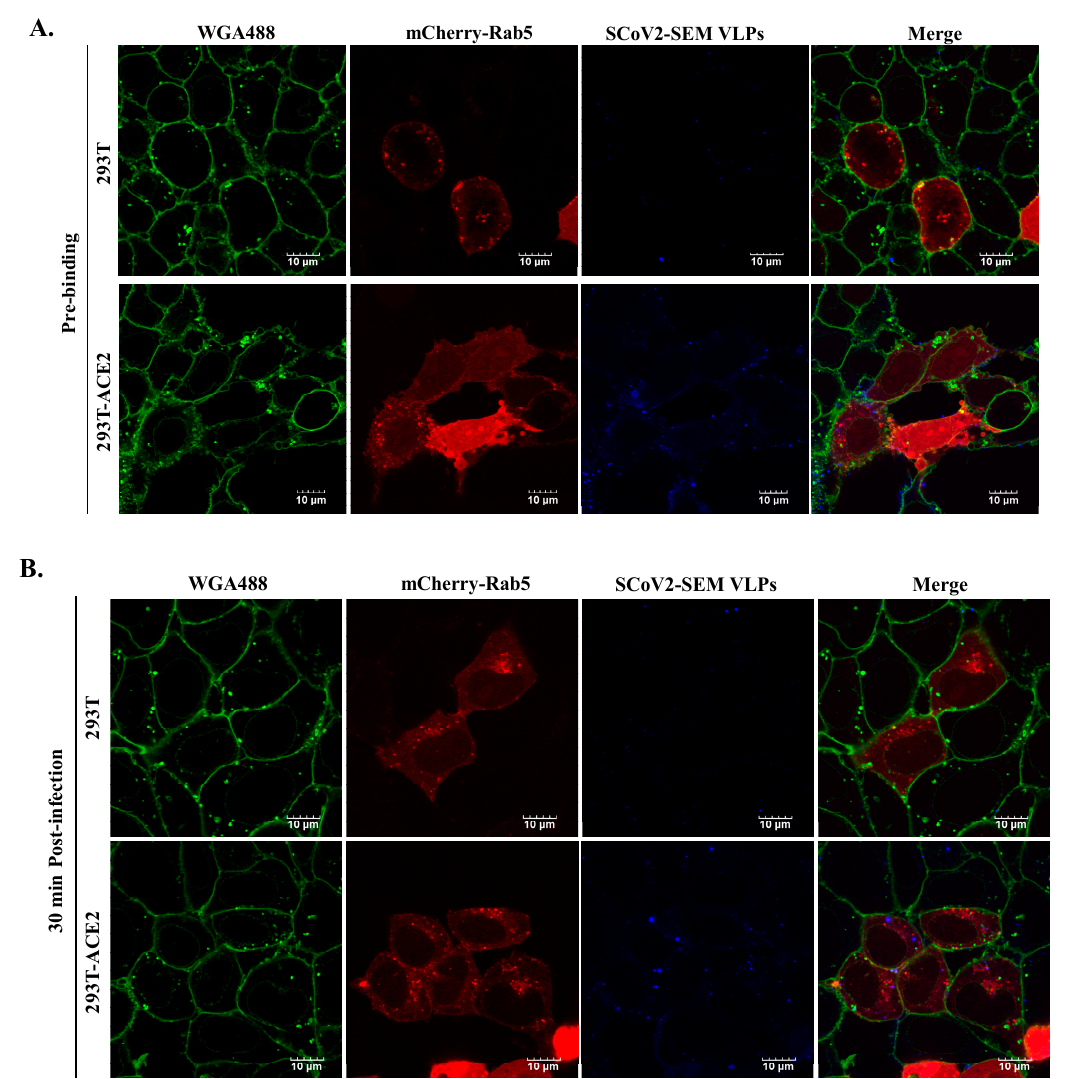
Figure 6. The ACE2-dependent infection of SCoV2-SEM VLPs. Atto647N-tagged SCoV2-SEM VLPs infected either HEK-293T or HEK-293T-ACE2 according to the procedure described previously. The confocal images were acquired after 4 °C incubation for 30 min ( A ). The post-infection images were acquired at 30 min after temperature switch ( B ). Cellular membrane stained with WGA488 was shown in green, mCherry-Rab5-indicated early endosome was shown in red, and Atto647N-tagged SCoV2-SEM VLPs were depicted in blue. Scale bar, 10 μ m.